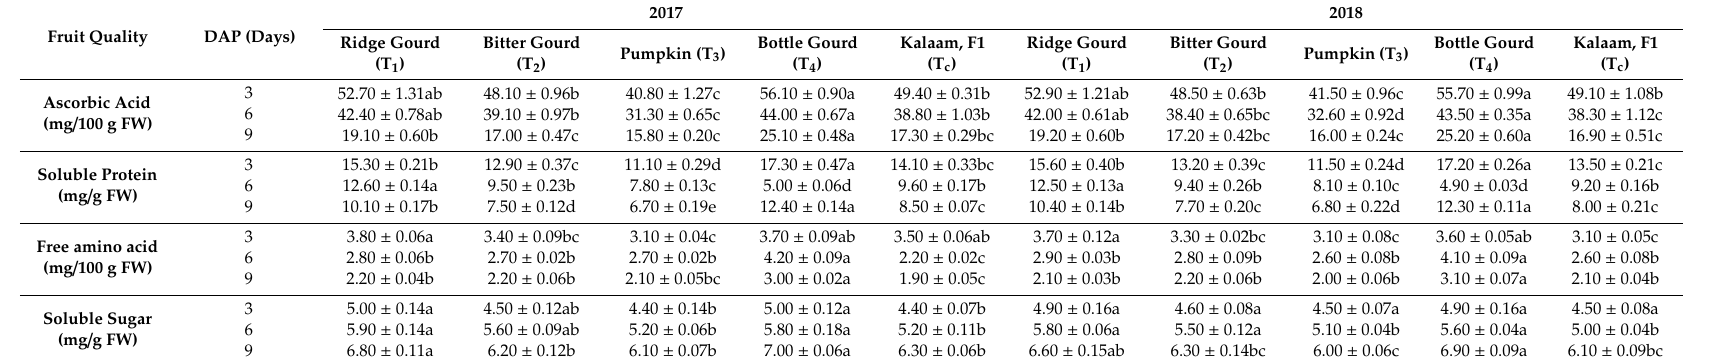
Table 5. E ff ect of Scion / rootstocks combinations (grafting) on Cucumber fruit quality. Fruit